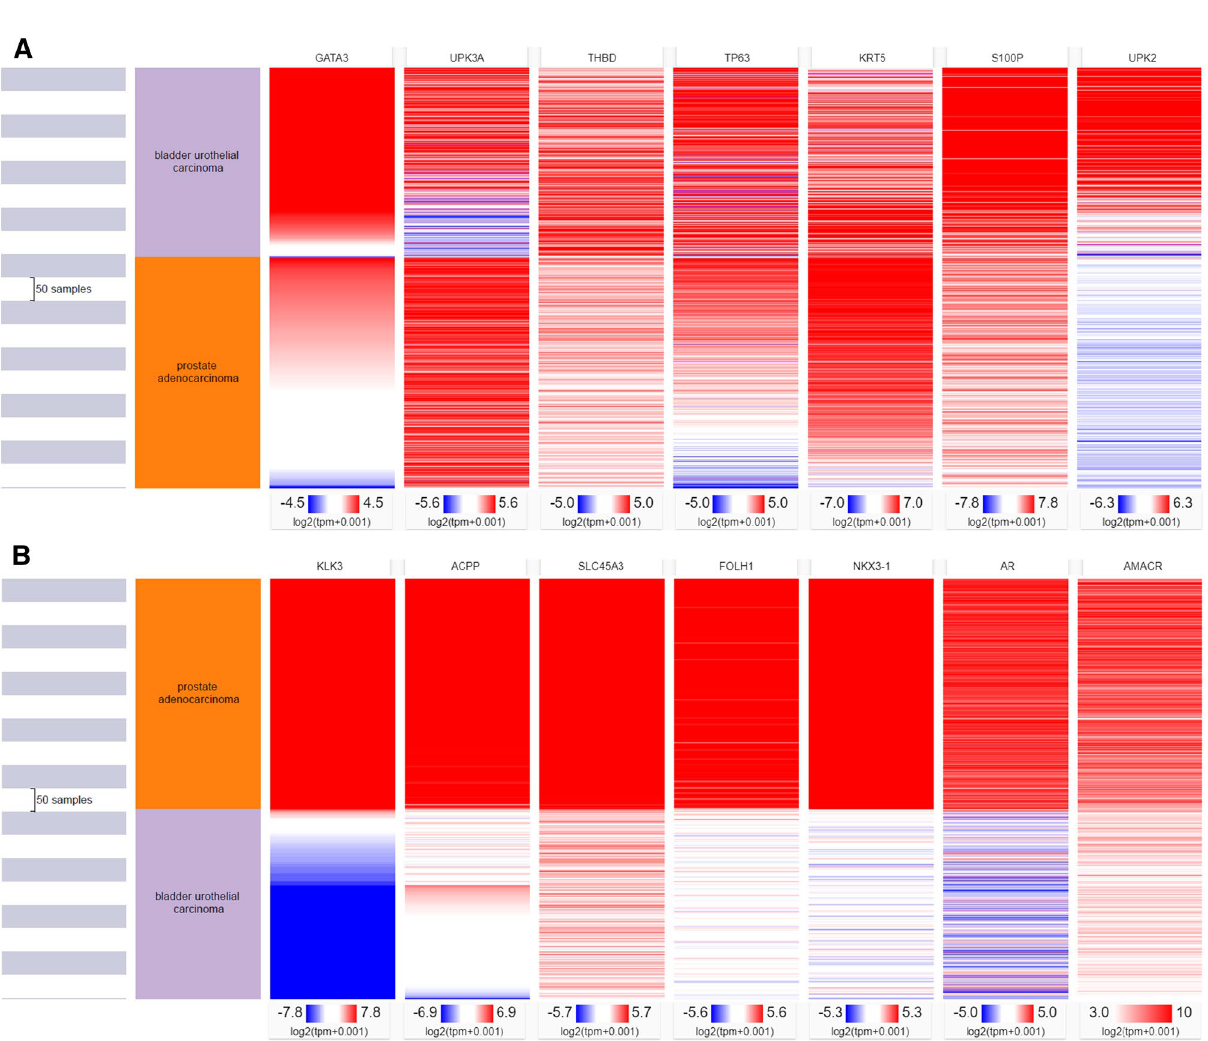
Figure 1. (A) Heat map for expressions of genes corresponding to the urothelial lineage markers (prepared using Xena Browser, accessed and analyzed online on 19 September 2020, https:// xenab rowser. net/). (B) Heat map for expressions of genes corresponding to the prostate lineage markers (prepared using Xena Browser, accessed and analyzed online on 18 September 2020, https:// xenab rowser.